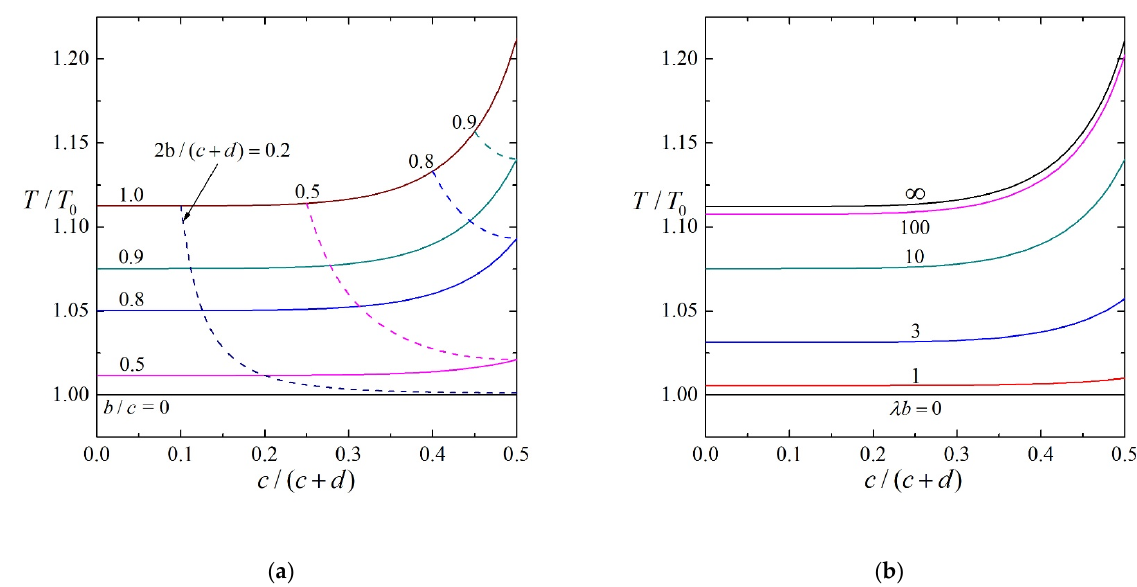
b / c , and relative position parameter c / ( c + d ) are presented in Figures 5–8 (together with Table A2), respectively, over the entire ranges. Again, T / T 0 increases as b / c increases from Figure 3. Normalized torque 0 / TT for a porous sphere ( 0 a  ) rotating about a diameter per- unity at b / c = 0 to a finite value at b / c = 1 and increases as c / ( c + d ) increases from a pendicular to two planar walls vs. the spacing parameter / b c : ( a ) finite value at c / ( c + d ) = 0 to another at c / ( c + d ) = 1/2, keeping the other parameters unchanged. Also, T / T 0 is a monotonic increasing function of λ b from a constant (equal to zero for the entirely porous limit a / b = 0) at λ b = 0 (the porous surface layer is completely permeable) to a great one as λ b → ∞ (the surface layer is impermeable).